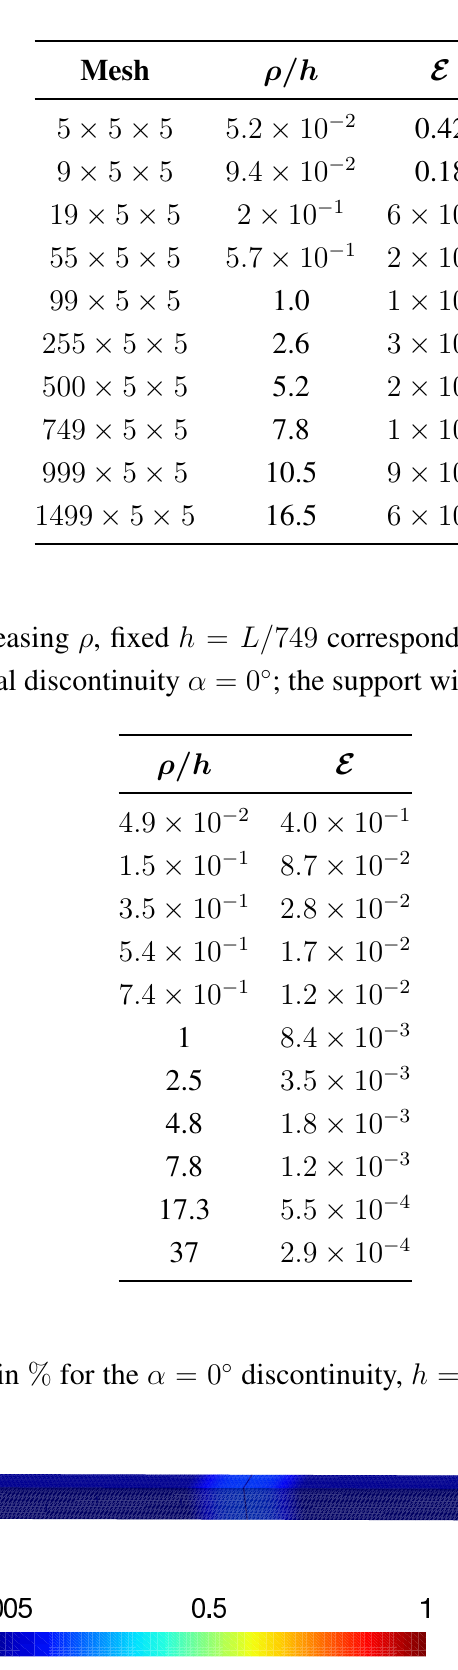
Table 3. Error for decreasing h , fixed ρ = L/ 100 , vertical discontinuity α = 0 ◦ ; the support = 20 ρ . width is ℓ ρ